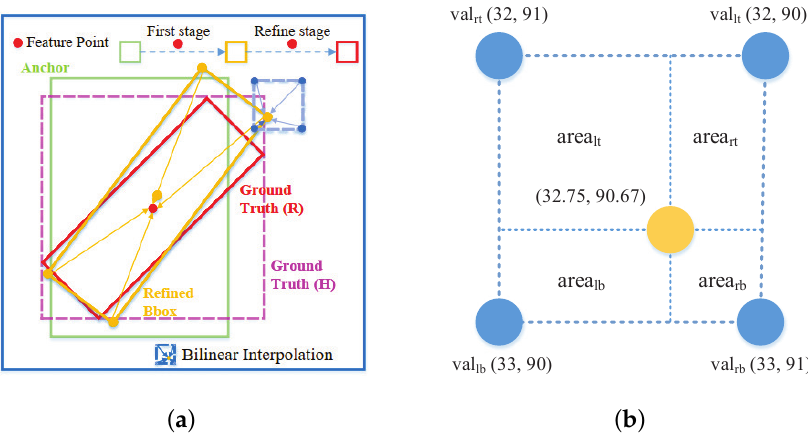
Figure 8. Feature refinement. ( a ) Refine the bounding box with aligned features. ( b ) Feature bilinear